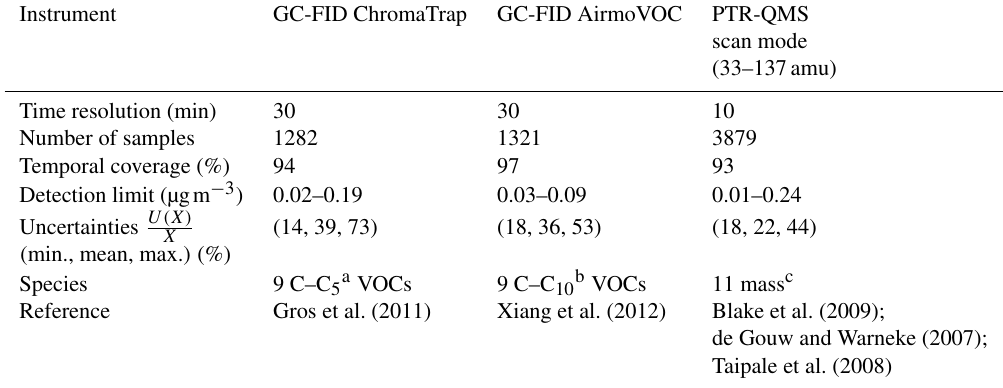
Table 1. Details of techniques and measurements of VOCs from 1 to 29 March